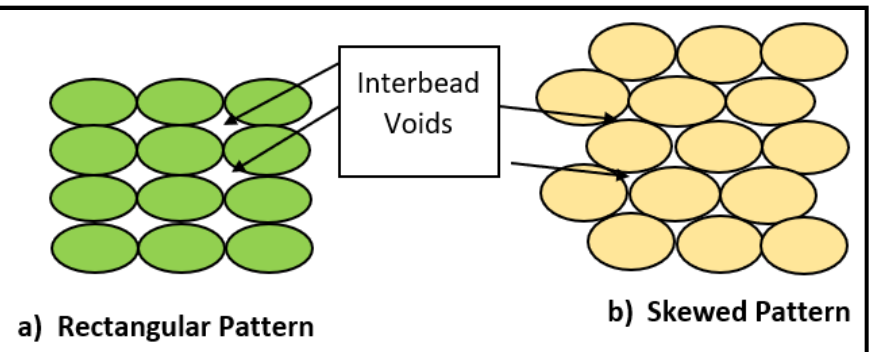
Figure 19. Schematic illustration of interbead void formation under different printing strategies ( a ) Rectangular pattern ( b ) Skewed pattern (redrawn from [78]).